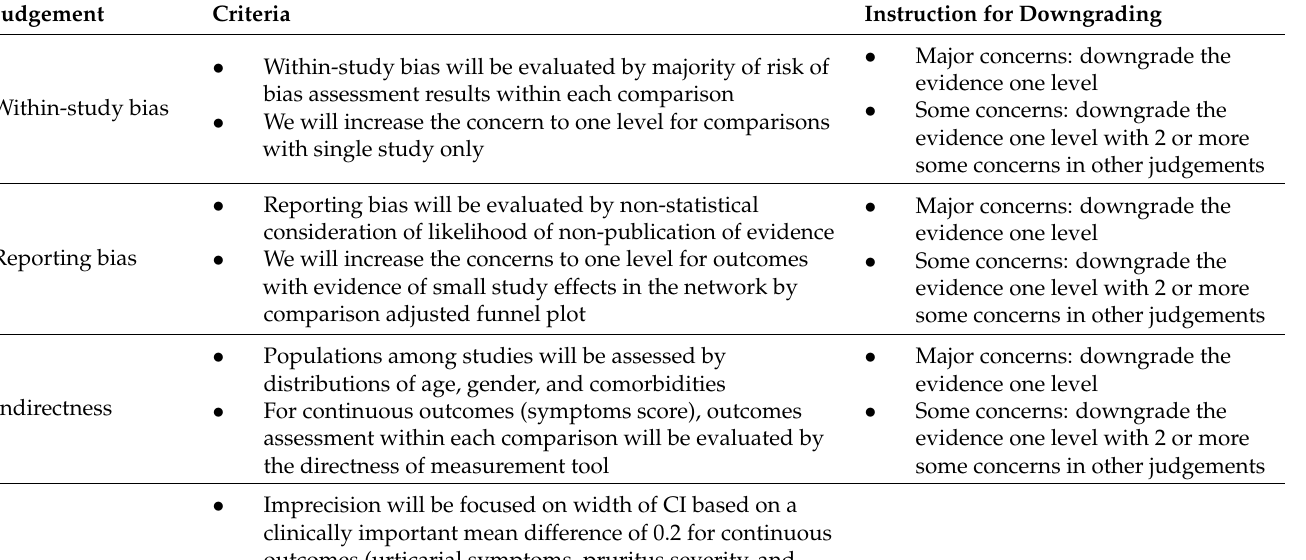
Table 3. Modified criteria for certainty assessment based on CINeMA and GRADE approach